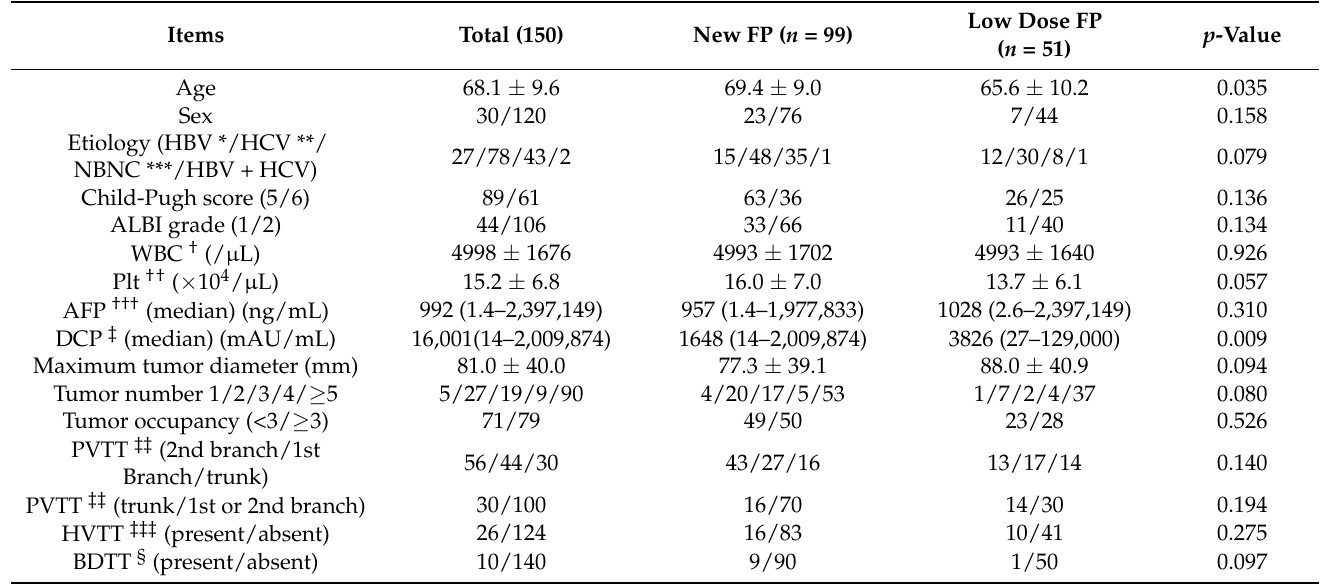
Table 1. Patient and tumor characteristics in this